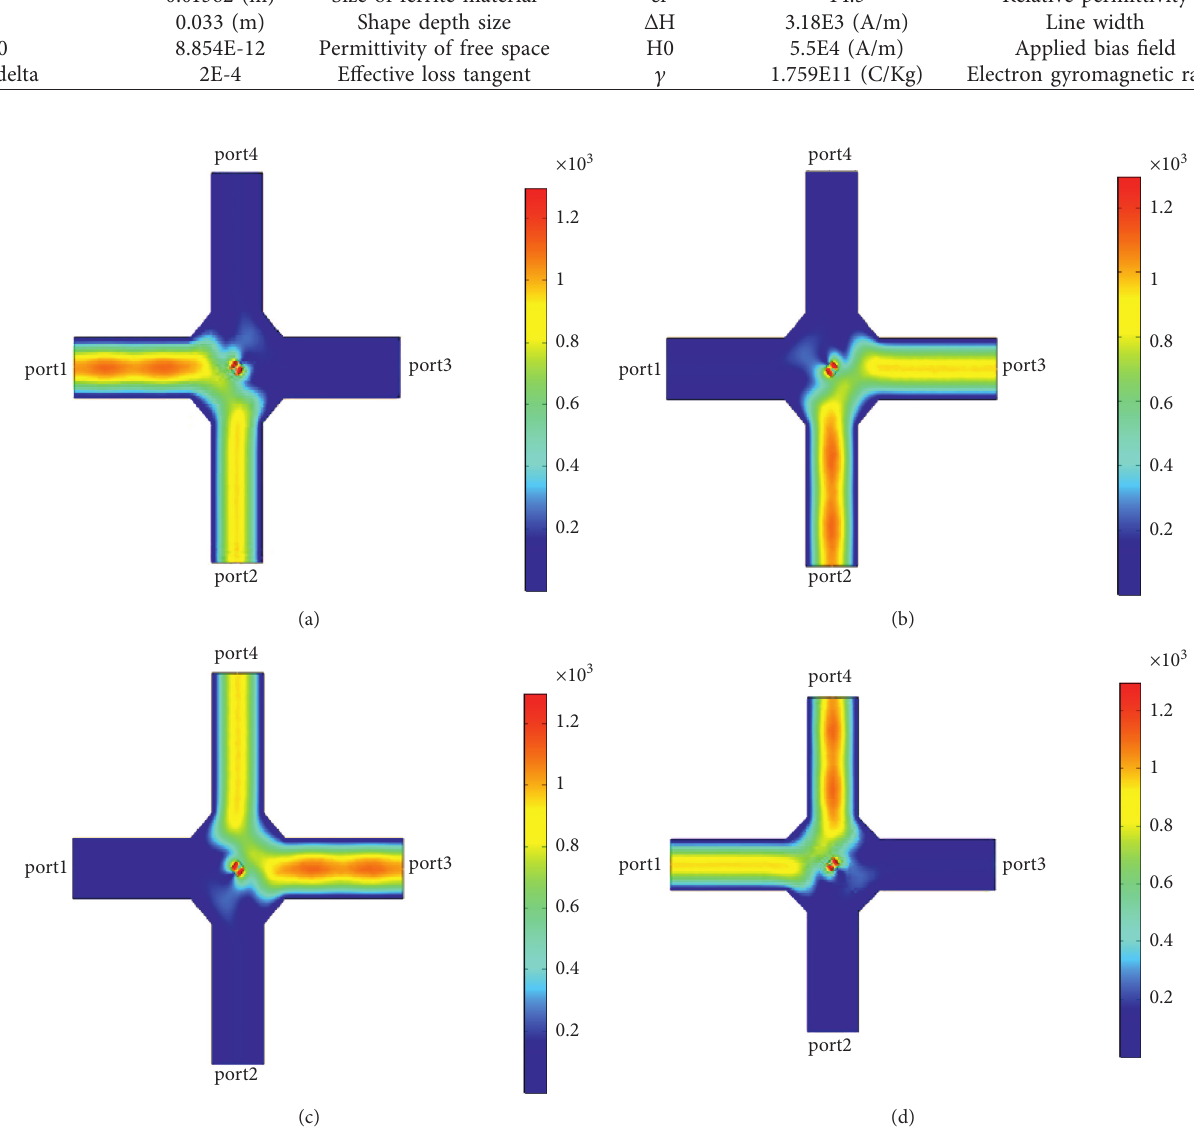
Figure 3: Four-port circulator: (a) enters from port 1 and exits to port 2, (b) enters from port 2 and exits to port 3, (c) enters from port 3 and exits to port 4, and (d) enters from port 4 and exits to port